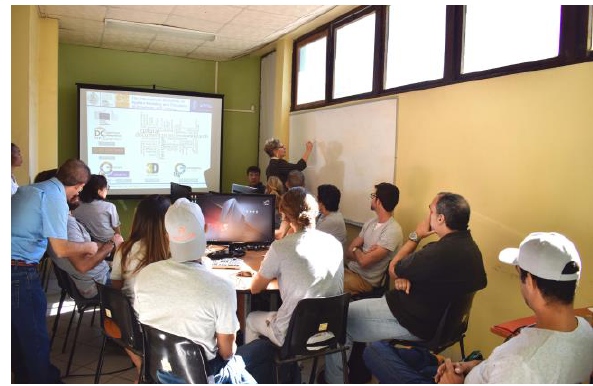
Figure 2. Theoretical in-class activities at the Departamento Diagnóstico y Levantamiento – Empresa de Proyectos de Arquitectura y Urbanismo